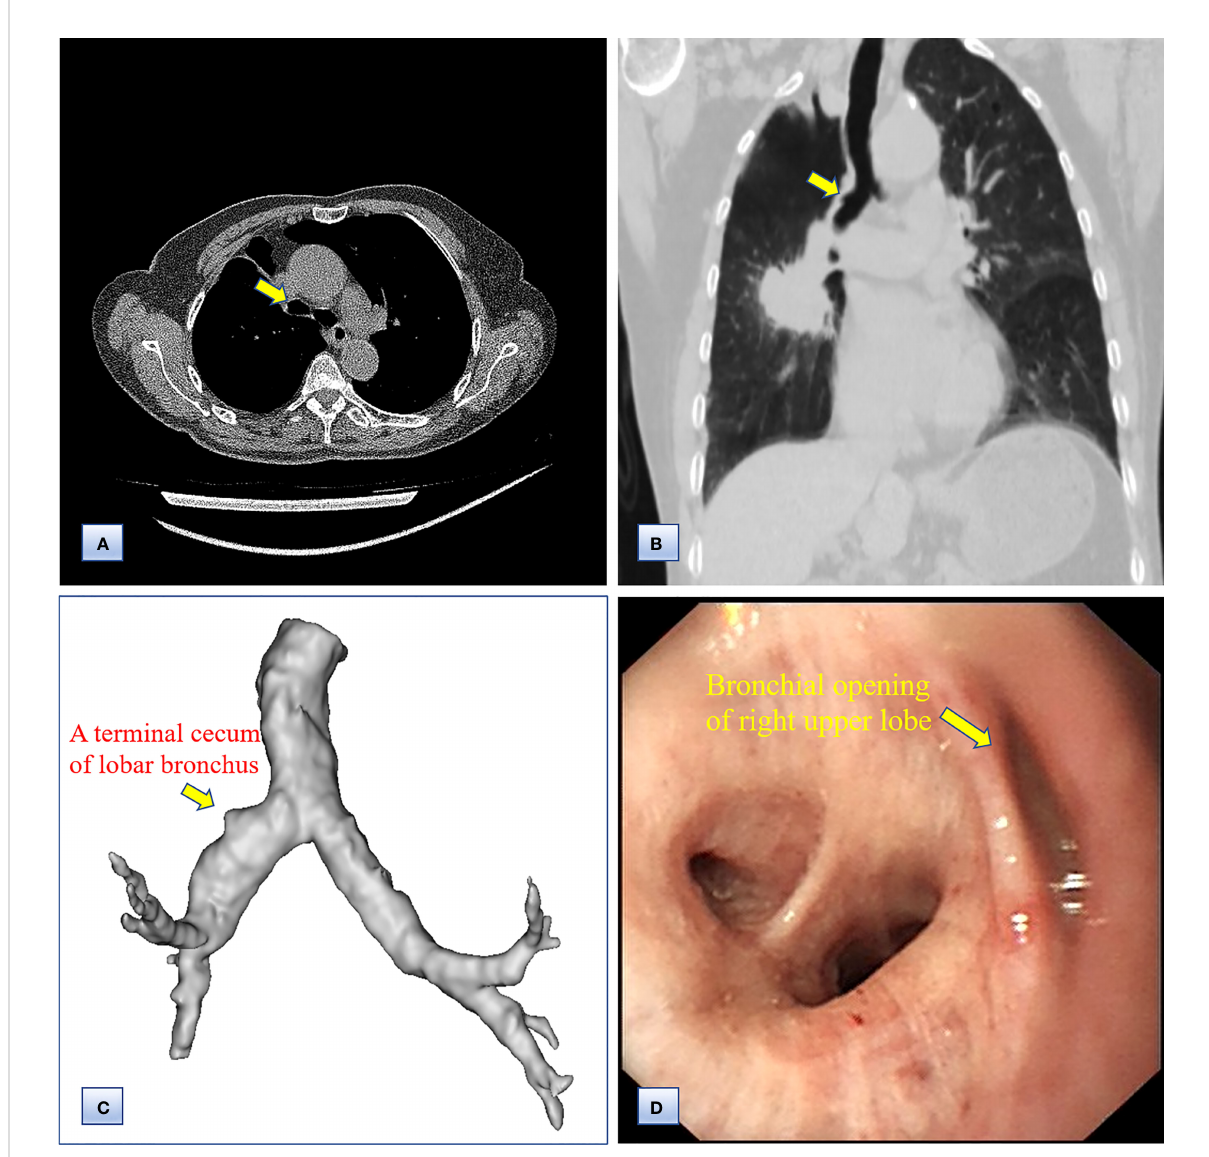
FIGURE 2 Computed tomography and bronchoscopy examination of the bronchi before surgery. (A, B) Axial (A) and coronal (B) chest CT images, showing the bronchus of the right upper lobe as a bud. (C) 3D CT reconstruction, indicating that the bronchus of the right upper lobe was a terminal cecum, and that the bronchial tree had not formed at the distal end. (D) Bronchoscopy examination, con fi rming the undeveloped bronchial primordium and ruling out a secondary